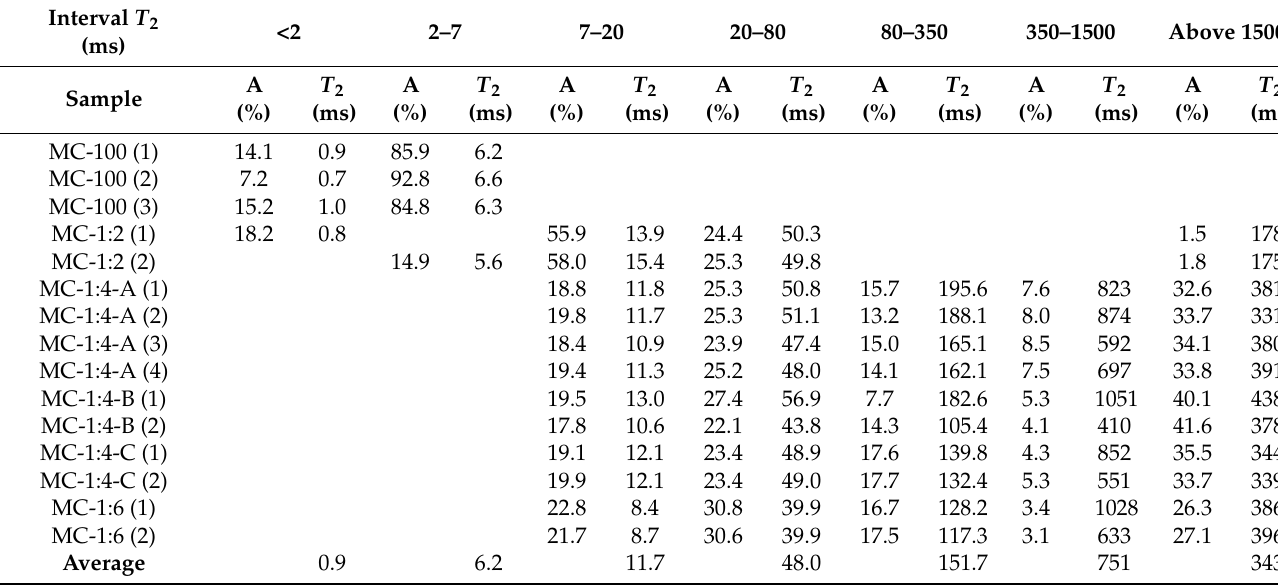
Figure 5. Grouping of relaxation times values obtained on the different samples (logarithmic scale on vertical axis) into different intervals. Table 5. Values of relaxation times ( T 2 ) and amplitudes ( A ) for all studied samples belonging to appropriate intervals.